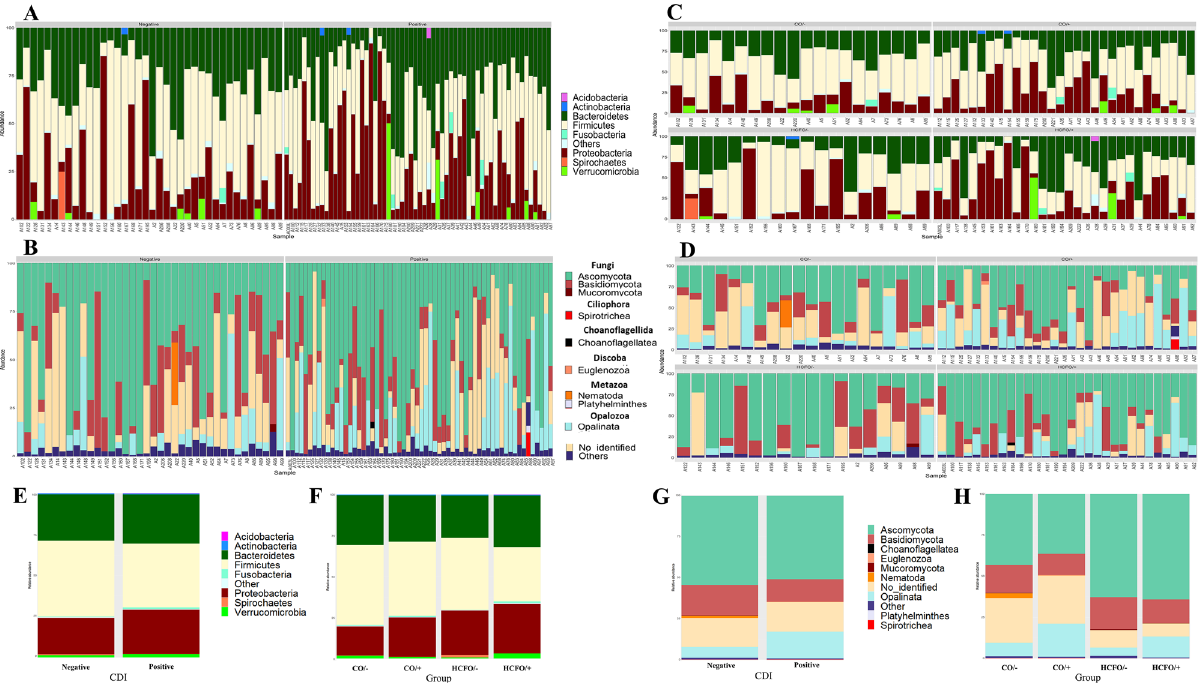
Figure 1. Microbial composition of diarrheic patients’ gut microbiota by CDI status and by group (HCFO/+ , HCFO/−, CO/+, CO/−). ( A ) Bar plots showing the 9 major bacterial phyla by CDI status. ( B ) Bar plots of major eukaryotic groups by CDI status. ( C ) Bar plots of major bacterial phyla by group. ( D ) Bar plots of major eukaryotes by group. ( E ) Distribution of each bacterial phyla by CDI status. ( F ) Distribution of each bacterial phyla by group. ( G ) Distribution of eukaryotes by CDI status. ( H ) Distribution of eukaryotes by group. Figure created on R studio with ggplot package 64,69